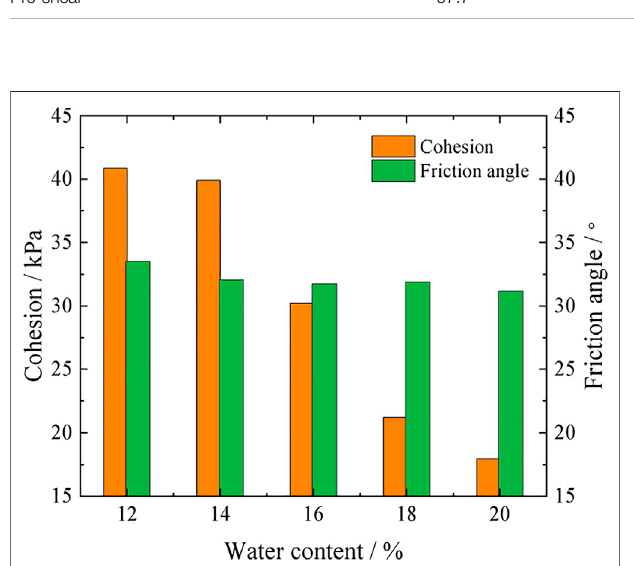
FIGURE 14 | The sample is extruded from the gap between the upper and lower shear boxes (w =